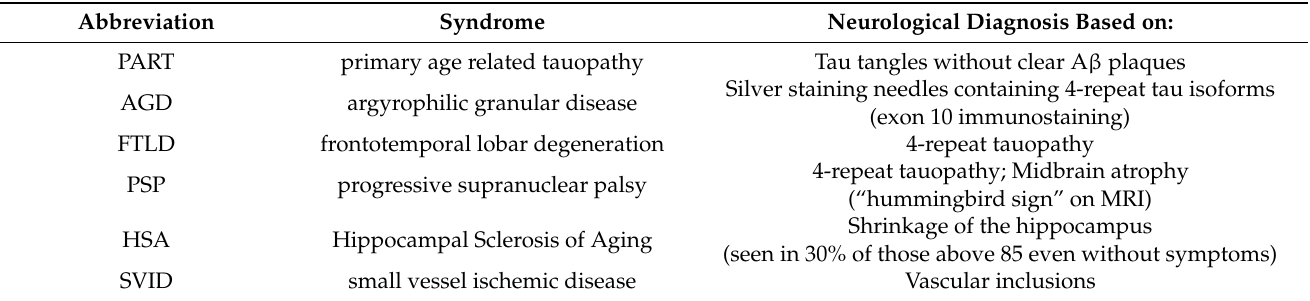
Table 2. Syndromes of aging that may also accompany AD and PD